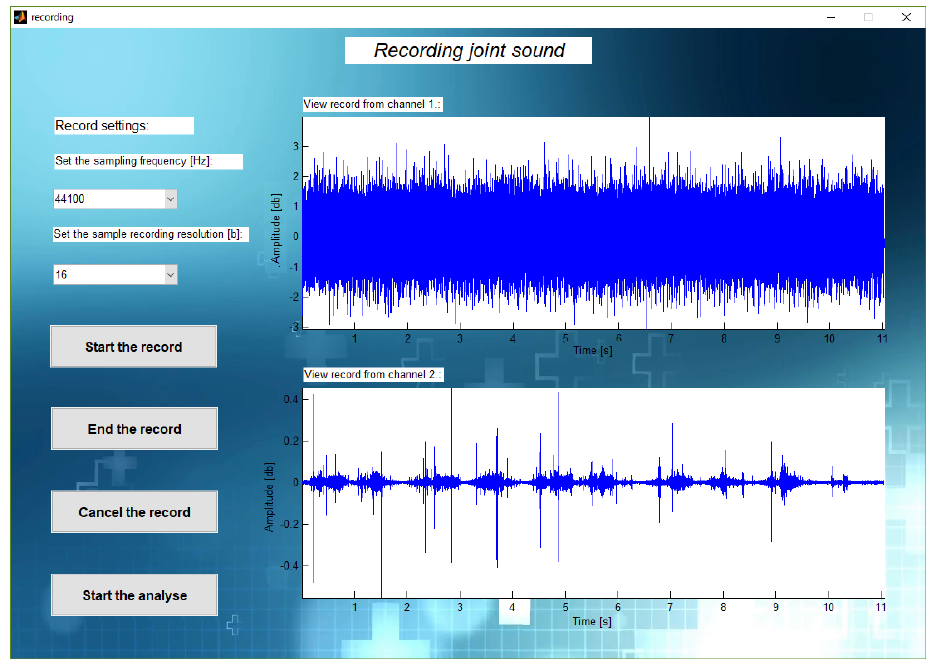
Figure 5. An example of a correctly received signal and an error while connecting the